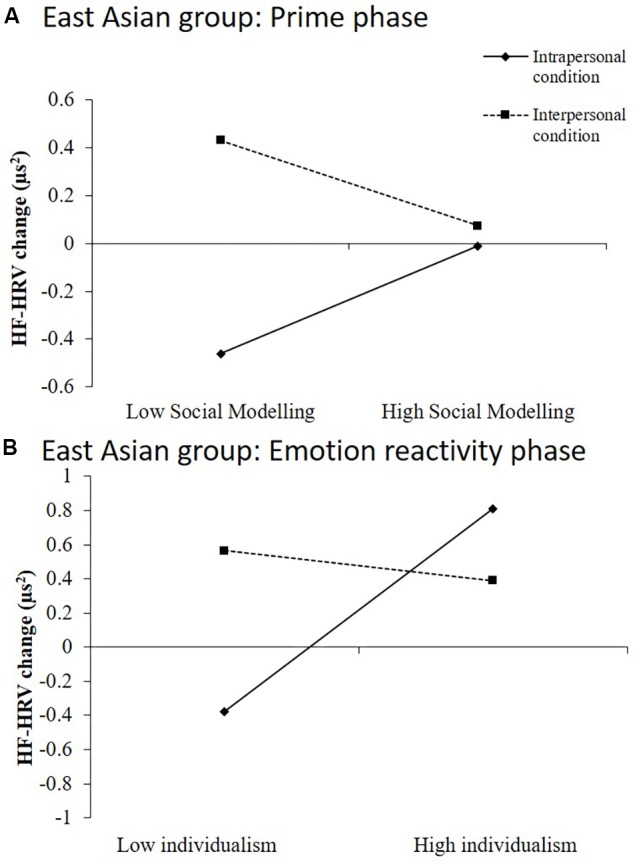
Significant interaction effects resulting from hierarchical moderated regression analyses performed with data from the East Asian group. (A) Habitual use of social modeling interacted with ER prime condition in the East Asian group. (B) Trait level of individualistic self-construal interacted with ER prime condition in the East Asian group.